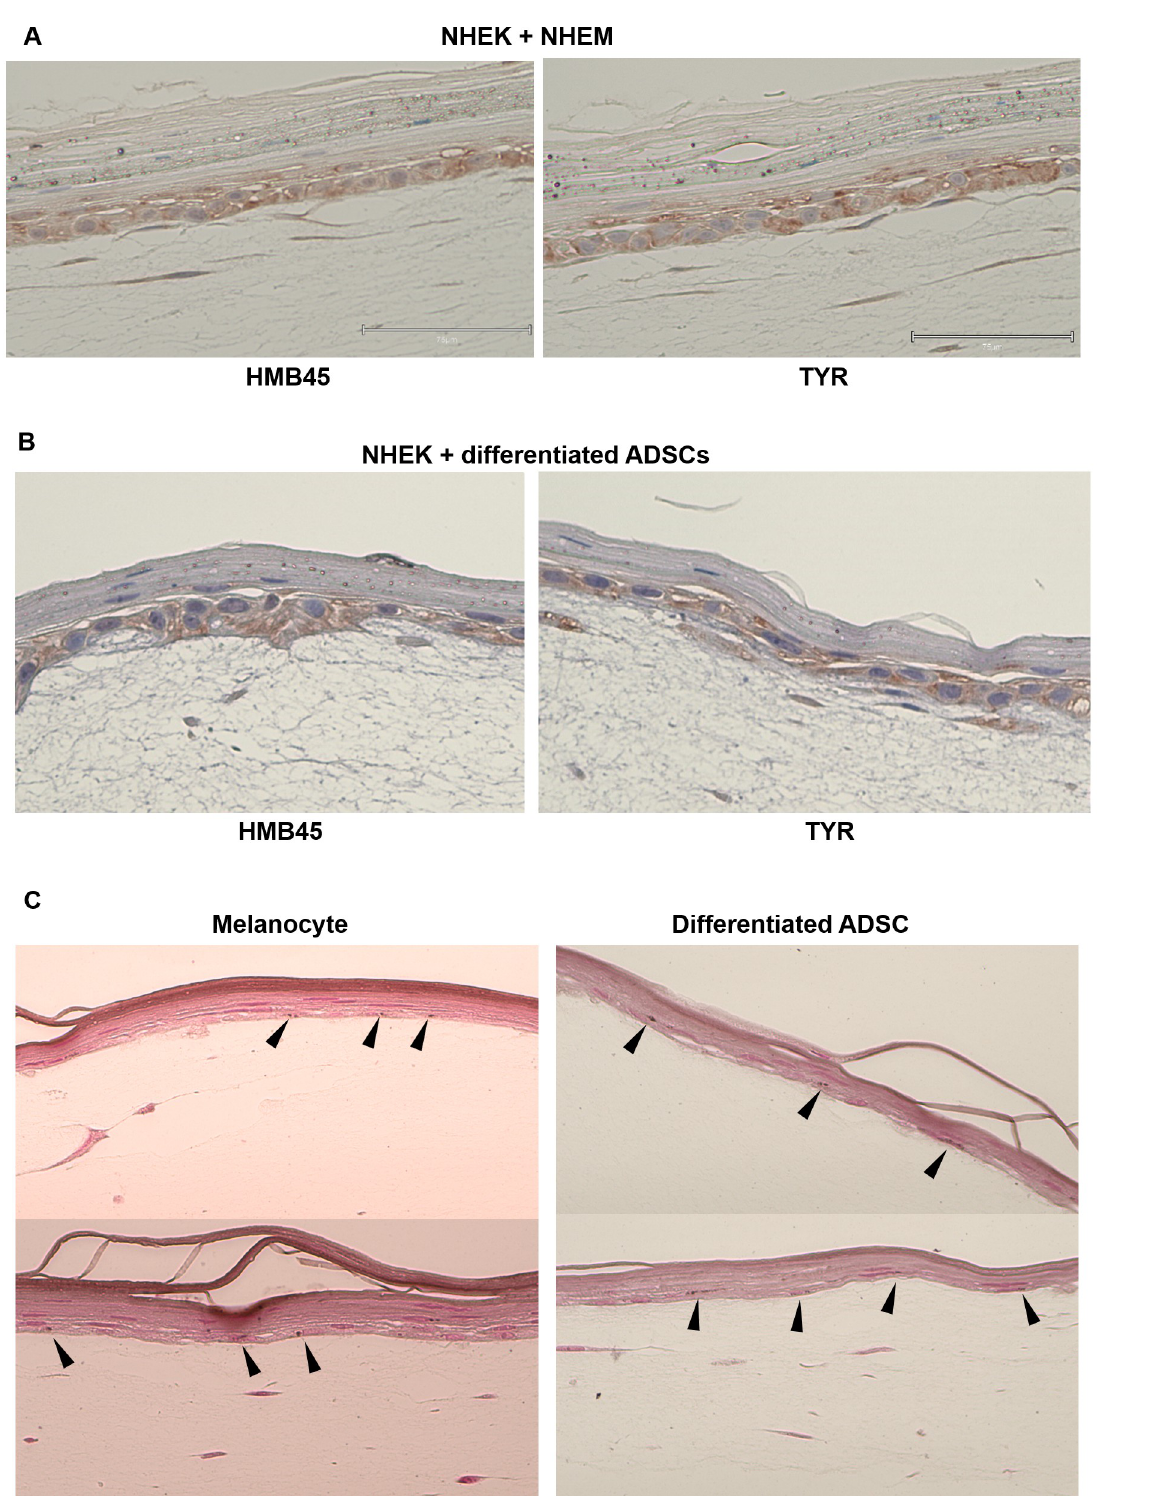
Fig 8. Three-dimensional epidermal culture using normal human epidermal keratinocytes (NHEKs) and normal human epidermal melanocytes (NHEMs) and NHEKs and differentiated ADSCs. HMB45- and tyrosinase (TYR)-positive cells were observed in the basal layer of both epidermis-like structures (A). Melanin deposits were induced by UVB irradiation in 3D epidermal culture using NHEKs and NHEMs, as well as in NHEKs and differentiated ADSCs and were detected by Fontana-Masson staining (B). https://doi.org/10.1371/journal.pone.0256622.g008 PLOS ONE | https://doi.org/10.1371/journal.pone.0256622 August 25,